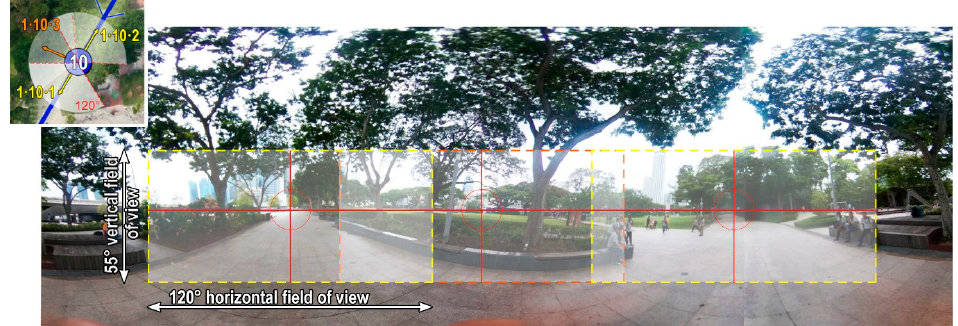
Figure 3. Schematic illustration of the 3 viewing angles (1·10·1, 1·10·2 and 1·10·3) extracted from a 360° photo taken at the point 1·10 of the Path 1-Esplanade Park. Yellow and orange dashed lines denote the view limits; red crossing lines denote view’s focal point.